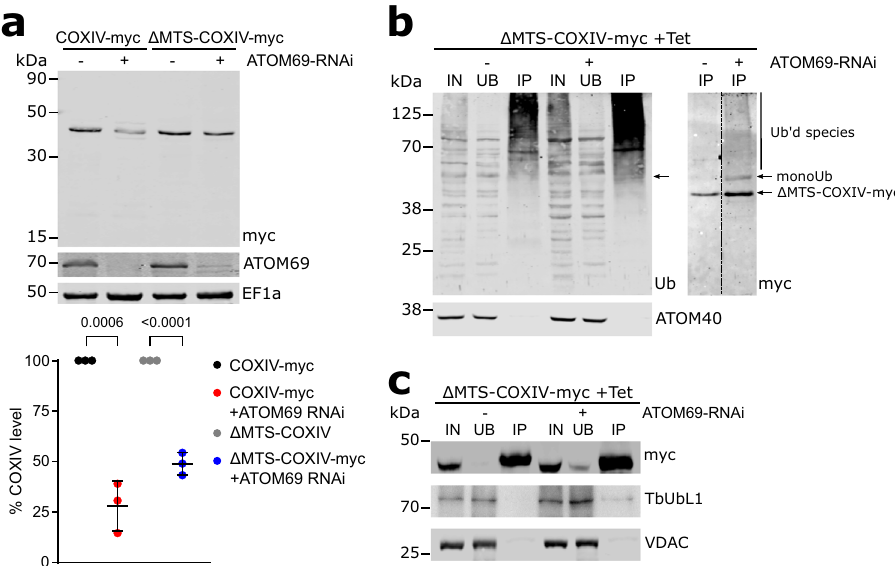
Fig. 8 Import de fi cient COXIV is ubiquitinated and interacts with TbUbL1. a Top panel, immunoblots of whole cell extracts of uninduced and induced atypical translocase of the outer membrane 69 (ATOM69) RNAi cell lines that simultaneously express c-terminally myc-tagged cytochrome oxidase subunit IV (COXIV-myc) or a derivative thereof that lacks the mitochondrial targeting sequence ( Δ MTS-COXIV-myc). The immunoblot was probed for the myc-tagged COXIV variants, ATOM69 and elongation factor 1a (EF1a), which serves as a loading control. Bottom panel, quanti fi cations of the levels of the myc-tagged COXIV variants from triplicate immunoblots shown in the top panel, with the COXIV-myc level of each uninduced cell line set to 100%. The level of COXIV-myc for each sample was normalised to its respective EF1a signal. Data are presented as mean values with error bars corresponding to the standard deviation of the mean from three independent biological replicates. Signi fi cance calculated using a two-tailed unpaired t -test, with the p values calculated indicated in the graph. b Immunoprecipitation (IP) using ubiquitin-binding Ubiqapture beads of whole cell extracts of the uninduced and induced (3d) ATOM69 RNAi cell line that expresses Δ MTS-COXIV-myc. 5% whole cell extracts (IN), 5% of the unbound protein fraction (UB) and 50% of the fi nal eluate (IP) were separated by SDS PAGE. The resulting immunoblots were probed with an antiserum against ubiquitin (left panel, Ub) or for Δ MTS-COXIV-myc (right panel, myc). ATOM40 (bottom panel) is used as a negative control. Arrow indicates a band of monoubiquitinated Δ MTS- COXIV-myc detectable by both anti-Ub and anti-myc. This IP analysis was repeated independently twice with similar results. c IP using myc conjugated beads with whole cell extracts of the uninduced and induced (3d) ATOM69 RNAi cell line that expresses Δ MTS-COXIV-myc. 5% whole cell extracts (IN), 5% of the unbound protein fraction (UB) and 50% of the fi nal eluate (IP) were separated by SDS-PAGE. The resulting immunoblots were probed for the myc-tagged COXIV variants (top panel), TbUbL1 (middle panel) and VDAC, which serves as a loading control (bottom panel). This IP analysis was repeated independently twice with similar results. Source data are provided as a Source Data fi